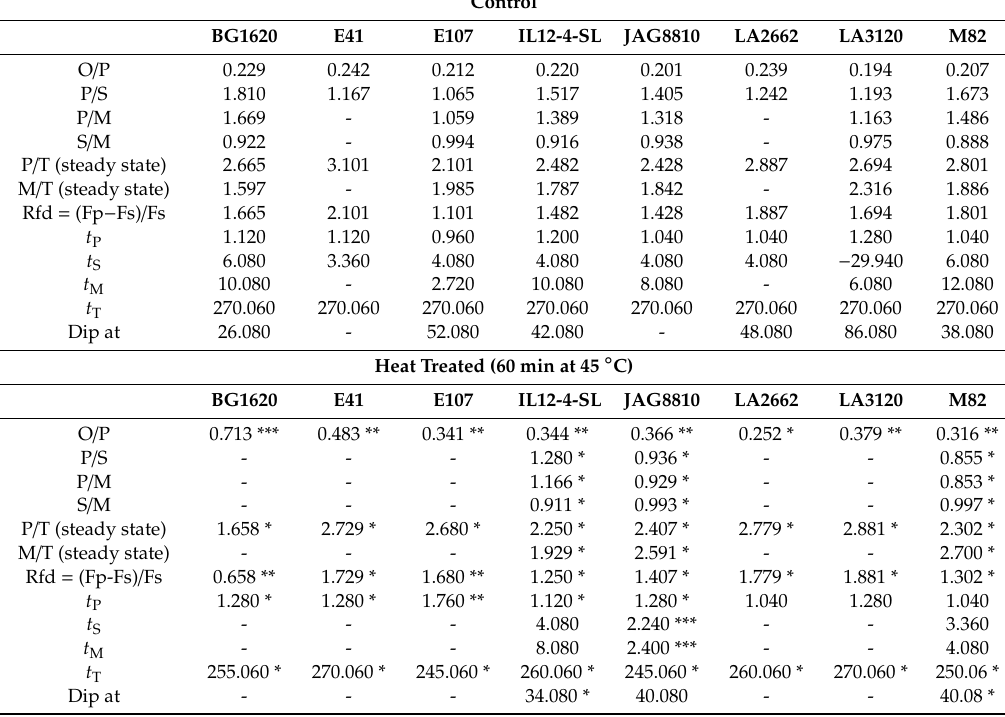
Table 3. Heat-induced changes in chlorophyll fluorescence parameters characterizing the shape of slow Kautsky kinetics recorded for 8 tomato genotypes. Values are means of 5 replicates. Standard deviation (not shown here) was under 4% of means. Asterisks indicate the statistical significance of the di ff erence in heat treated leaves compared to their respective non-treated control (* 0 to 50%; ** 50 to 100%; *** over 100%). O (origin) = minimum fluorescence level (also termed F 0 ); P = peak fluorescence level reached after 1–2 s of actinic light exposure; S = semi-steady state of fluorescence emission; M = maximum of fluorescence; T = terminal steady state chlorophyll fluorescence of the slow Kautsky kinetics; Fp = fluorescence peak; Fs = fluorescence steady state; Rfd = relative fluorescence decline (vitality index); t P = time at which P fluorescence peak is reached; t S = time at which S fluorescence level is reached; t M = time at which M fluorescence level is reached; t T = time at which T fluorescence level is reached, Dip = decrease.